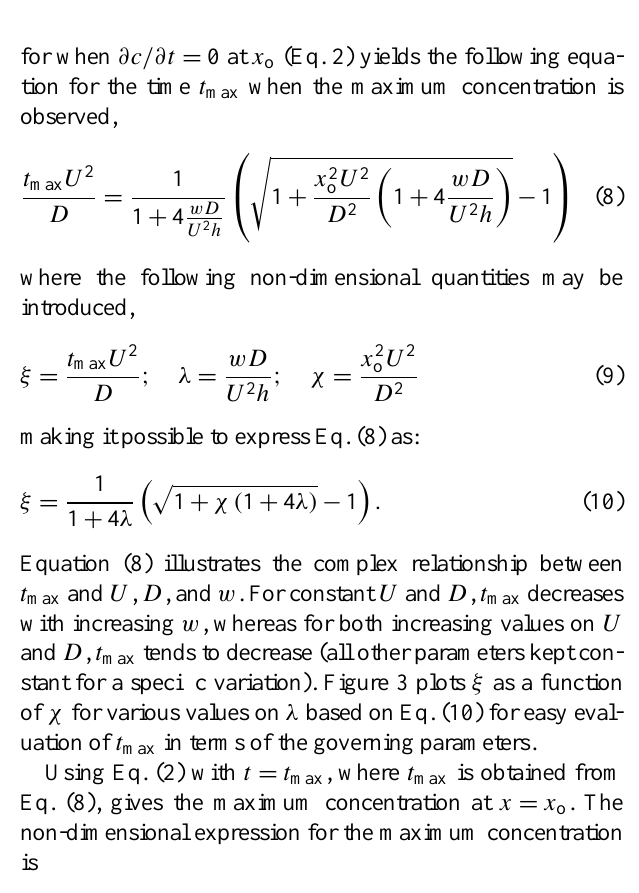
Fig. 3. Non-dimensional time for the occurrence of maximum con- location away from a pollution release as a function of non-dimensional distance and fall centration at a particular location away from a pollution release as speed. a function of non-dimensional distance and fall